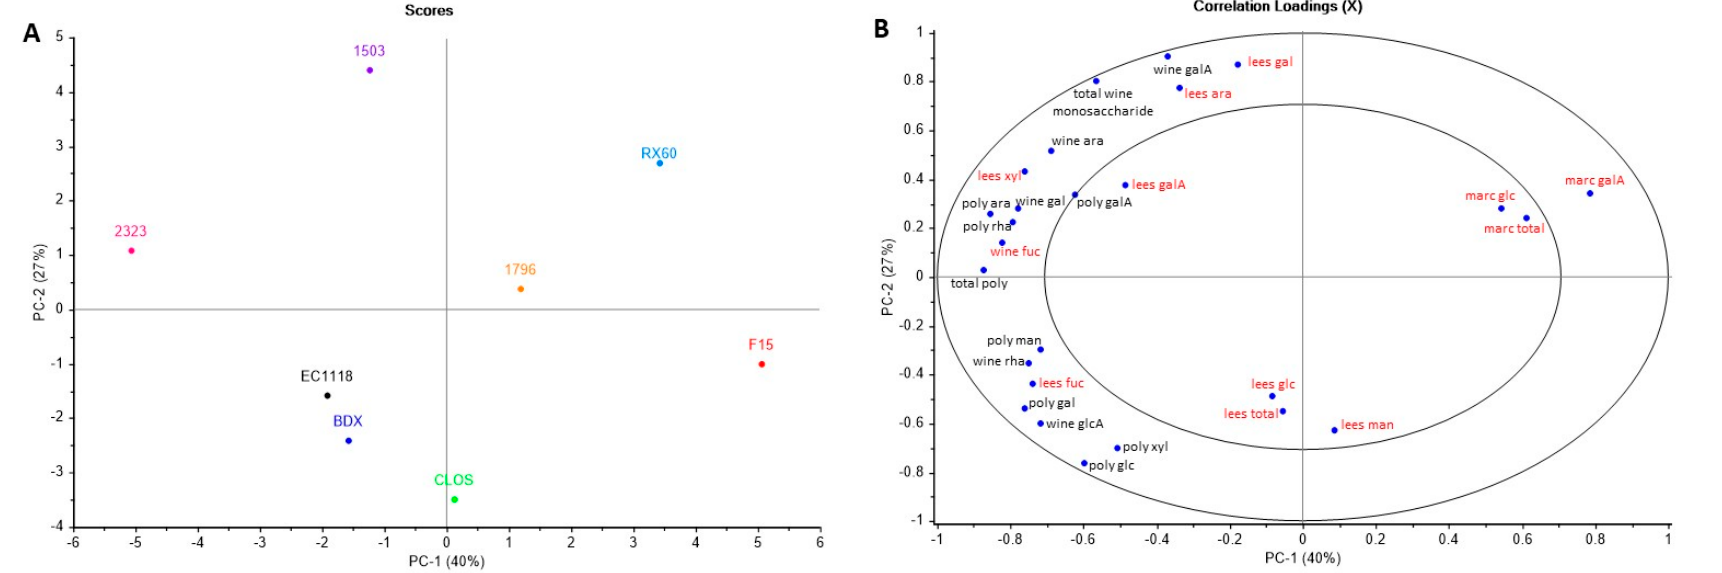
Figure 1. Principal component analysis of the composition of wine soluble (wine) polysaccharide-associated (poly) monosaccharides, and hydrolytically-released monosaccharides from purified lees and marcs of 8 commercial yeast strains ( A ) Scores plot showing each yeast strain as a different colour; ( B ) Correlation loadings plot for wine composition (black) and lees or marc composition (red). Abbreviations: man = mannose, rha = rhamnose, glcA = glucuronic acid, galA = galacturonic acid, glc = glucose, gal = galactose, xyl = xylose, ara = arabinose, fuc = fucose.